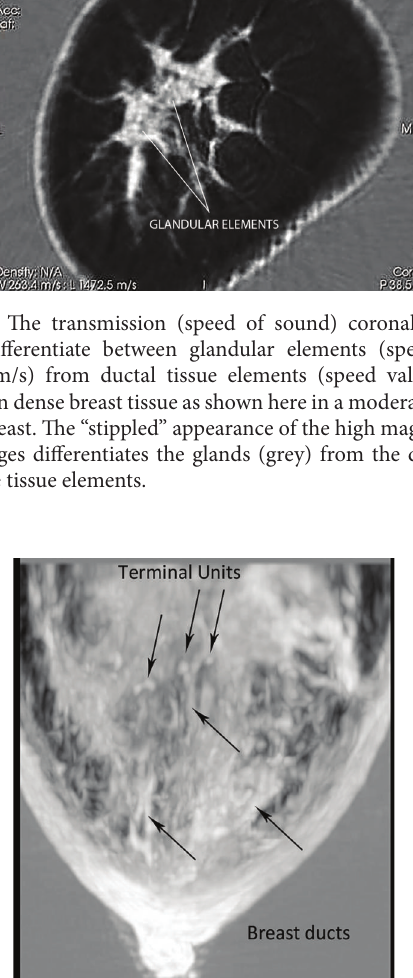
Table 3: Estimated proportion of breasts with equivalent or better image quality on QT Ultrasound by feature.